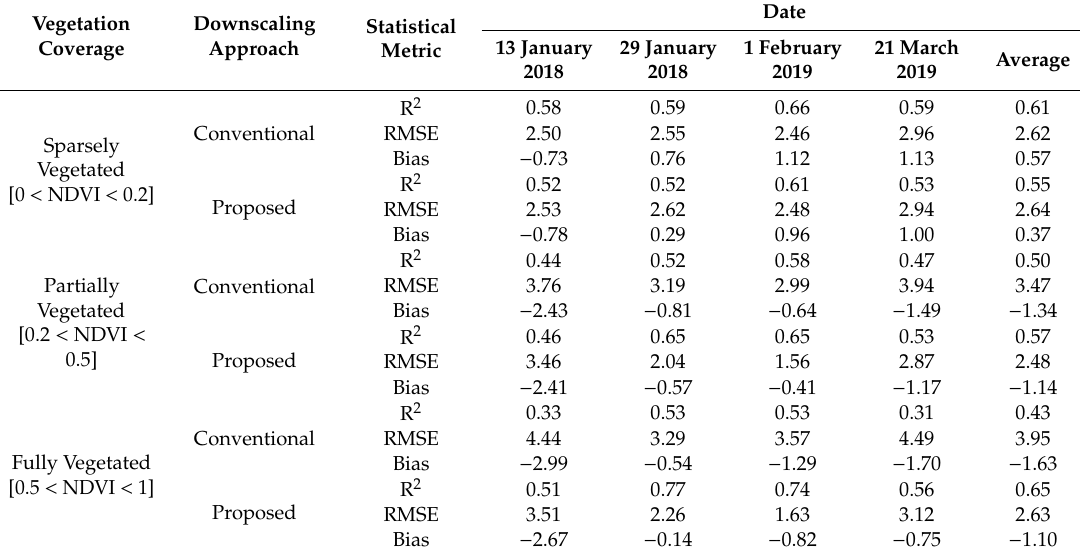
Table 5. Statistical results across three vegetation cover categories based on Table 2. Statistical results across three vegetation cover categories based on NDVI.